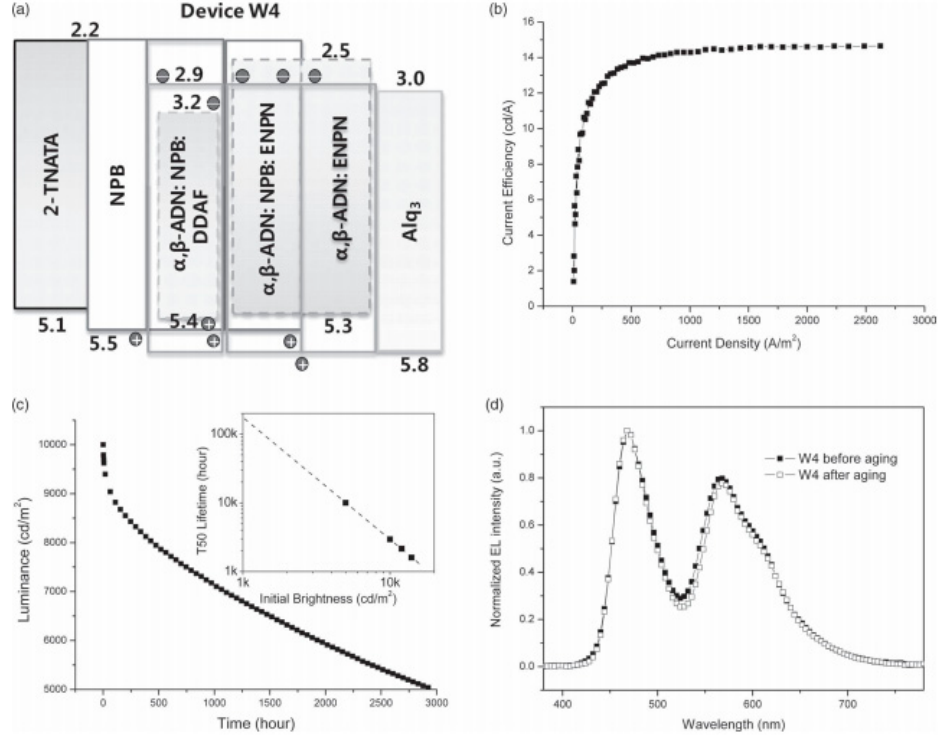
Figure 5. Characteristics of the optimized WOLED: ( a ) device structure; ( b ) CE versus density curve; ( c ) luminance decay curve; the inset shows the lifetime versus initial luminance relationship; ( d ) EL spectra before and after accelerated aging at 10,000 cd m − 2 . Reproduced from Reference [123].